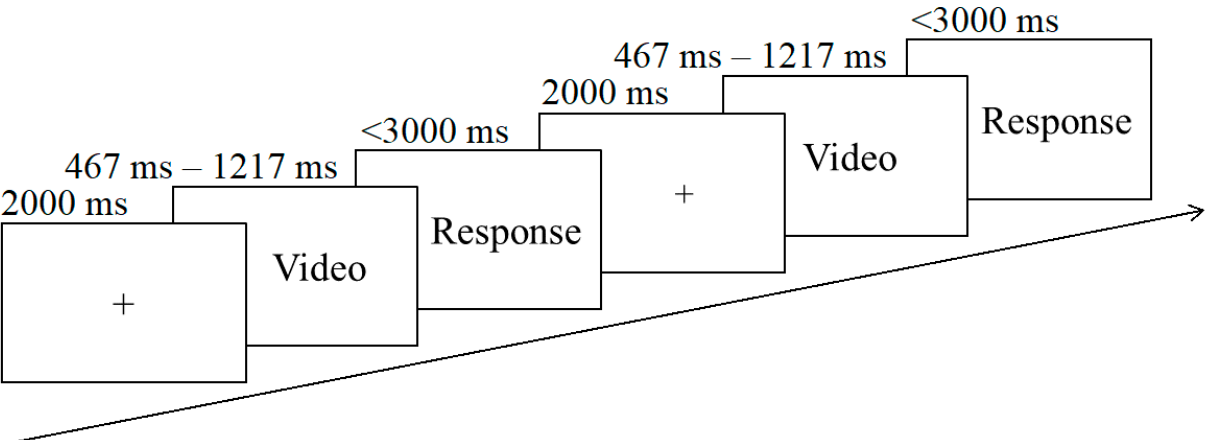
Figure 2. Example of trials.